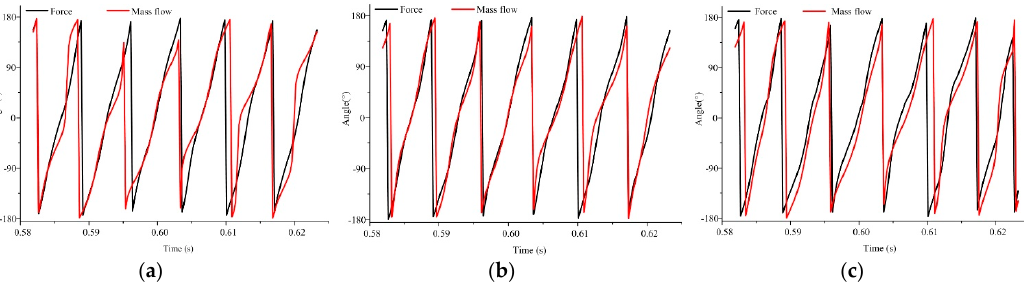
Figure 9. Time revolution of vector angles for principal axis force and total mass flow rate: ( a ) 0 mm; ( b ) 1 mm and ( c ) 2 mm.